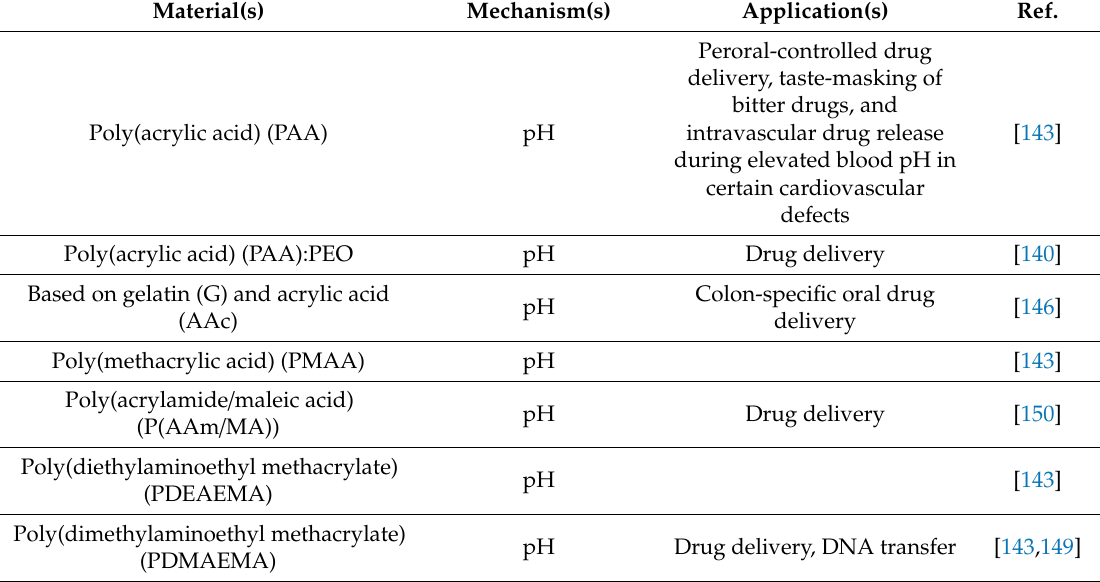
Table 6. Overview of the experiments on 4D (bio-)printing and other manufacturing approaches using pH as a predefined